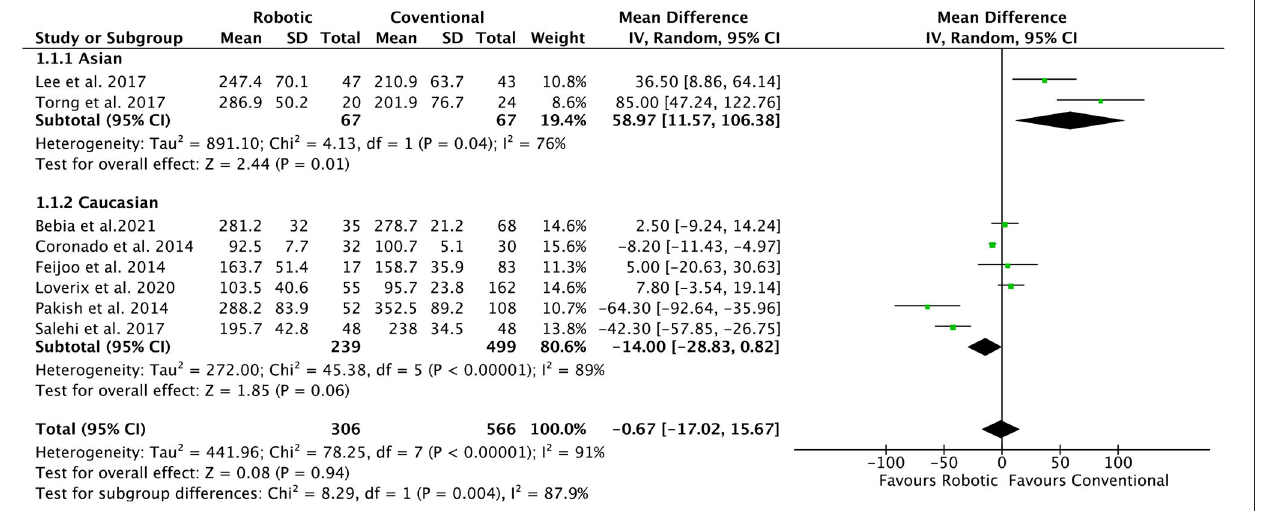
FIGURE 2 | Forest plot of the association of operation time in robotic-assisted vs. conventional laparoscopy for para-aortic lymphadenectomy in gynecological